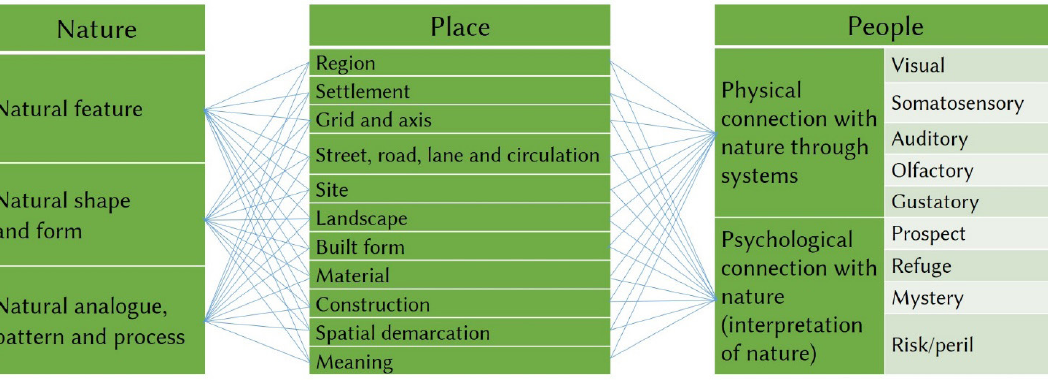
Figure 2. A matrix for observing biophilic design features (diagram by the